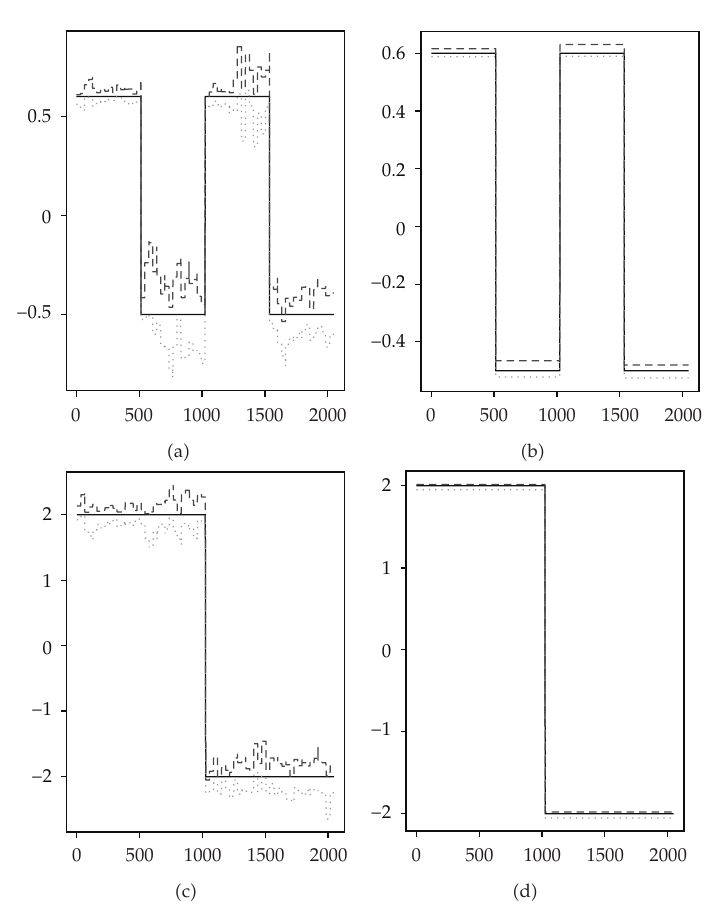
Figure 12: Example 5.3: Bootstrap 95% confidence regions for linear estimators, (cid:5) a (cid:6) and (cid:5) c (cid:6) , and nonlinear estimators, (cid:5) b (cid:6) and (cid:5) d (cid:6) , with true curves inside.